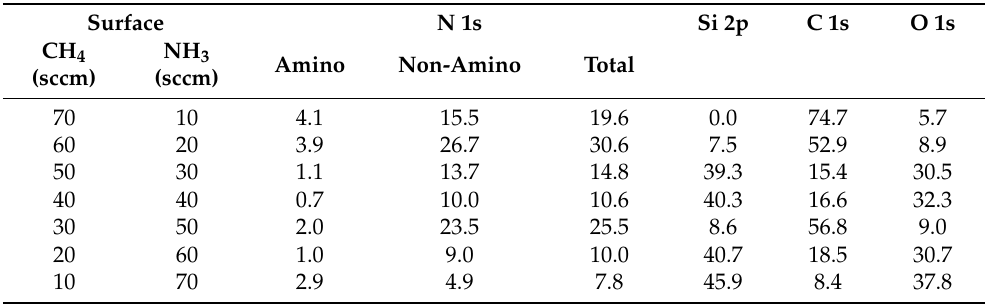
Table 2. XPS chemical compositions (%) of surfaces plasma-processed with CH 4 /NH 3 feeds (the relative amounts of gases are reported in the first two columns). The definitions for amino, non-amino, and total nitrogen are reported in Section 2.3. PE-CVD was performed at 200